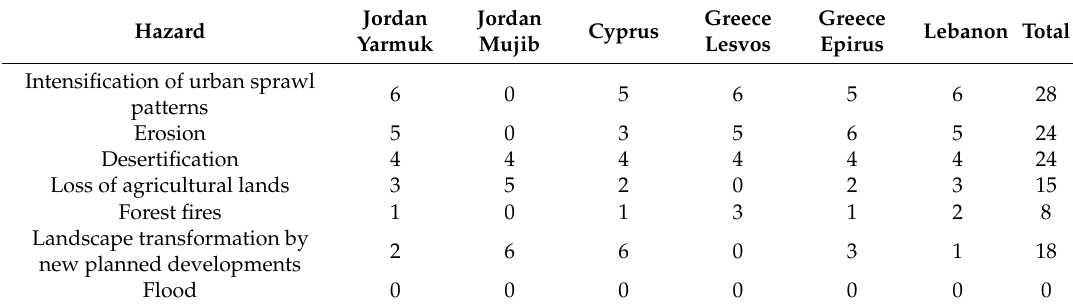
Table 1. Hazards ranking